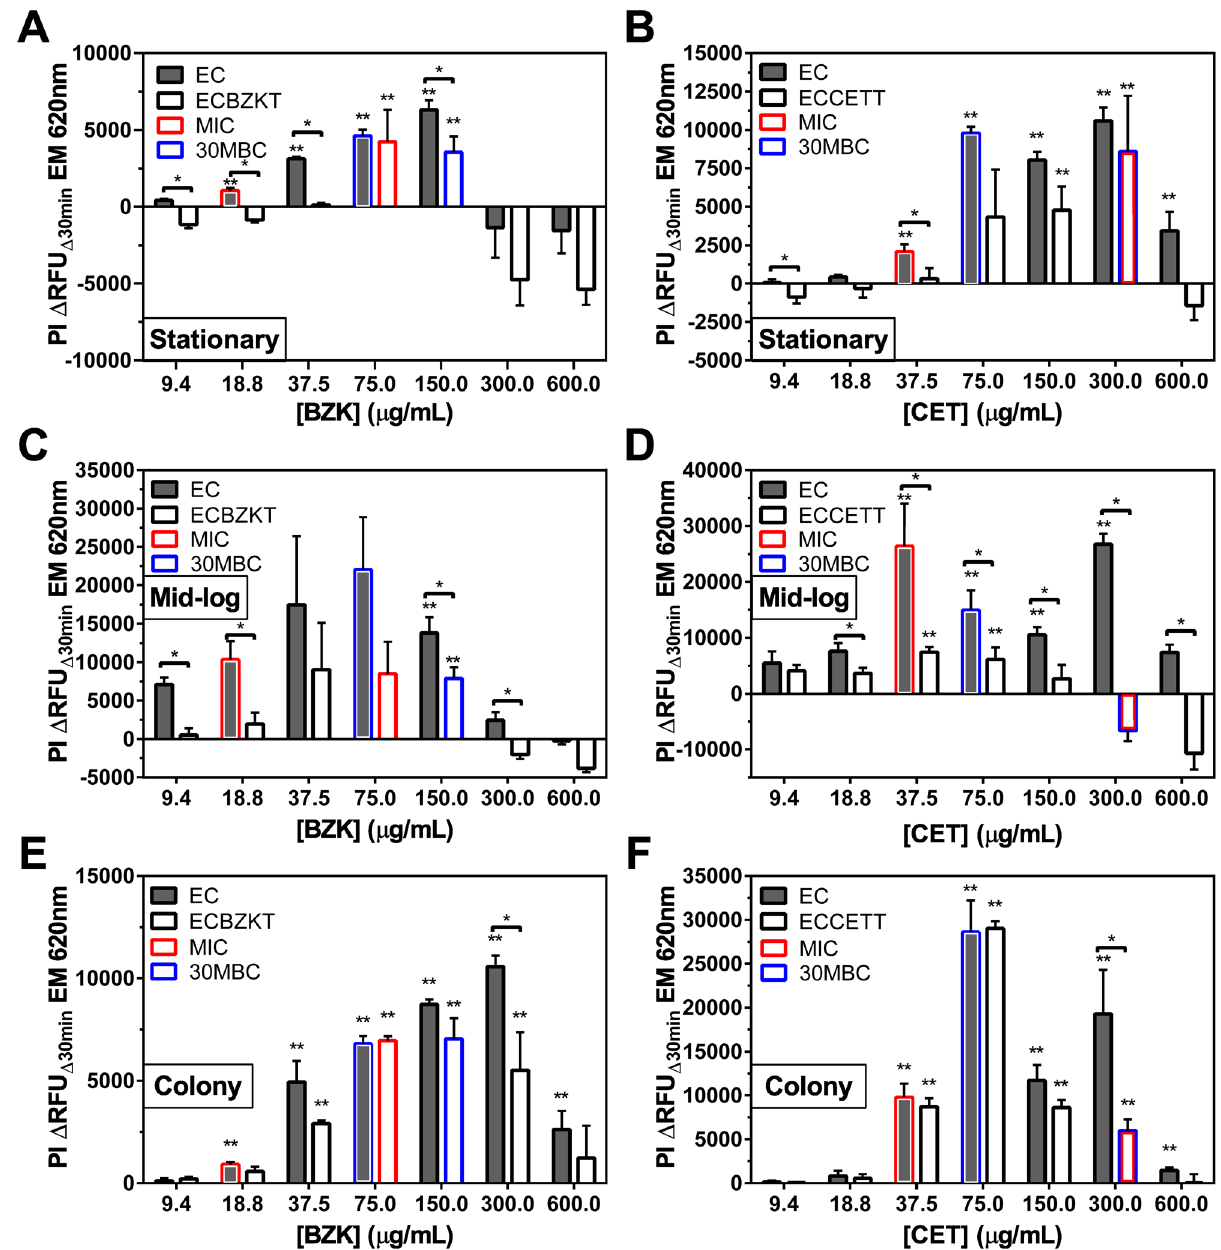
Figure 2. RFDMIA results of EC, ECBZKT, and ECCETT prepared as stationary phase ( A , B ), mid-log phase ( C , D ), and agar colony ( E , F ) PBS-buffered cell suspensions exposed to increasing concentrations of BZK ( A , C , E ) and CET ( B , D , F ). All graphs are show the mean PI ΔRFU Δ30min at EM 620 nm values from bacterial cell preparations at increasing QAC concentrations. Bar outlines are color coordinated to indicate the QAC concentration corresponding to the MIC (red) and 30MBC (blue) values of each isolate every panel as determined by AST on Table 1. For each RFDMIA plot shown, a Student’s two-tailed t test was calculated by comparing every QAC concentration PI ΔRFU Δ30min value to the lowest measured QAC concentration PI ΔRFU Δ30min value shown on the plot. This t test was used to identify the lowest QAC concentration with a significant increase in PI ΔRFU Δ30min value, which is indicated as a double asterisk (**) with P < 0.01. Data represents three bacterial bioreplicates (n = 3) measured from averaged technical triplicate